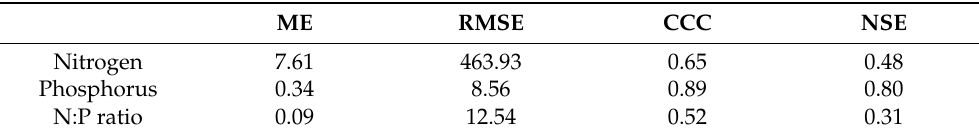
Table 3. Validation of nitrogen, phosphorus, and nitrogen-to-phosphorus ratio spatial predictions at point support. Abbreviations: ME: mean error, RMSE: root mean square error, CCC: Lin’s con- cordance correlation coefficient, NSE: Nash–Sutcliffe model efficiency coefficient, N:P ratio: nitro- gen-to-phosphorus ratio.